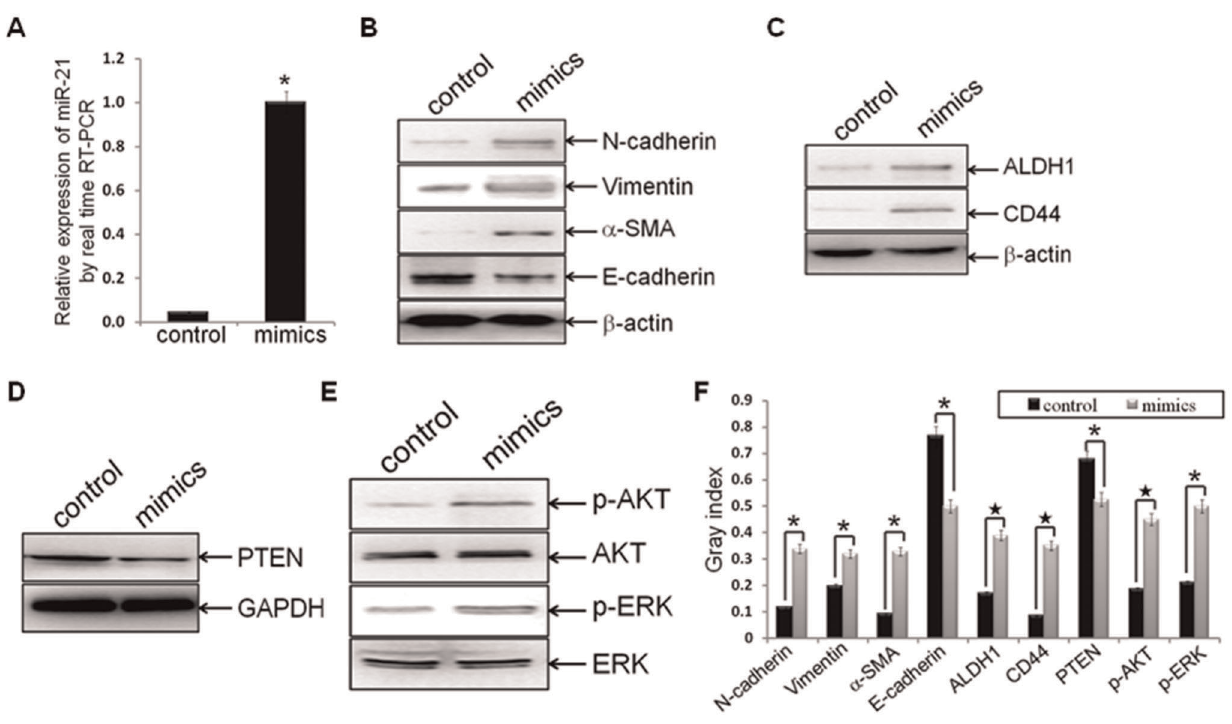
Figure 4. Hsa-miR-21 mimics induced EMT and CSC phenotype, accompanied with PTEN down-regulation and AKT/ERK1/2 activation. Established MDA-MB-231/anti-miR-21 cells were transfected with hsa-miR-21 mimics at a concentration of 40 nmol for 72 h. (A) MDA- MB-231/anti-miR-21 cells were treated with hsa-miR-21 mimics elevated the expression of miR-21, as compared to control groups (n1=n2=3; p=0.00373), by real-time RT-PCR analysis. (B-F) Protein levels of mesenchymal markers (N-cadherin, Vimentin and alpha-SMA) (B), epithelial marker (E- cadherin) (B), CSC markers (ALDH1 and CD44) (C), PTEN (D), p-AKT and AKT (E), as well as p-ERK1/2 and ERK1/2 (E) in indicated cells were measured by Western blot analysis, and bands were semi-quantified using ImageJ software (F). Beta-actin or GAPDH was used as loading control. (*indicates p , 0.05; w indicates p , 0.001).